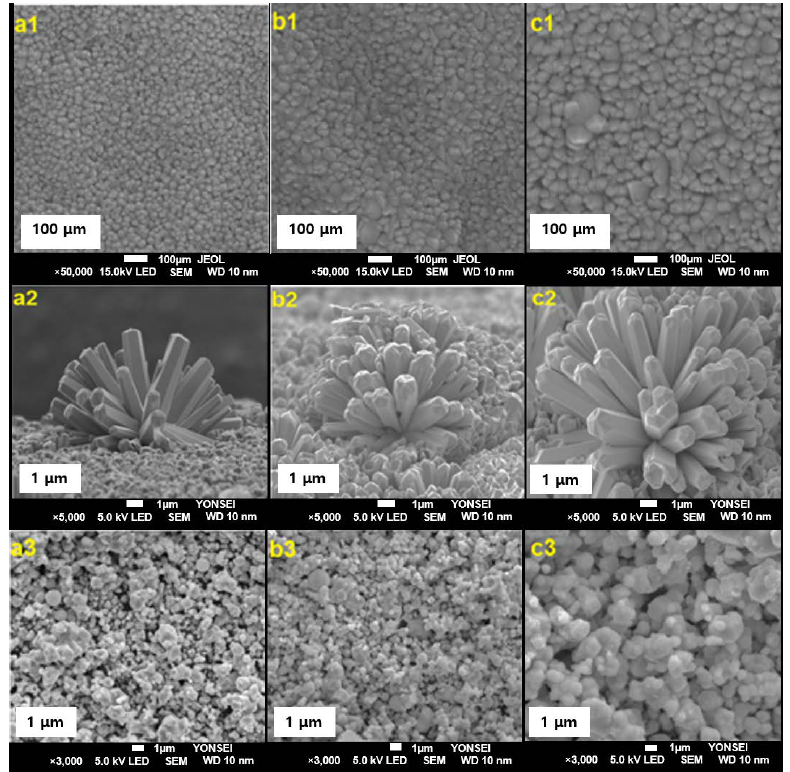
Figure 2. FESEM images of ZnO seed layer ( a1 , b1 , c1 ); ZnO microrods ( a2 , b2 , c2 ) and ZnO/V 2 O 5 composite ( a3 , b3 , c3 ) for deposition time of 10 min, 20 min, and 30 min respectively. Hydrothermally synthesized samples (ZnO and ZnO/V 2 O 5 ) experienced extremely oriented growth which were further studied by XRD and XPS techniques. The XRD studies were plotted in Figure S5 and Figure 3 for ZnO and ZnO/V 2 O 5 , respectively. The expected peaks distinctly appeared which indicate the formation of ZnO microrods for all samples with different deposition times. They showed similar 2 θ values of 31.72 ◦ , 34.38 ◦ , 36.2 ◦ , 47.54 ◦ , 56.62 ◦ and 62.78 ◦ independent of the deposition times as represented in Figure S5. Moreover, the crystallinity and orientation of synthesized ZnO microrods were studied by the intensity of ZnO peaks. The peak heights are slightly attenuated for the 10 min ZnO deposition sample signifying lower crystallinity. These peaks indexed the hexagonal phase of the crystalline structure match with the JCPDS card: (36-1451) [28]. No extra peaks confirm a well-crystalline and pure phase ZnO structure. The sharp diffraction peaks in all samples (Figure 3a–c) at the different seed layer sputtering time on PET films authorized the polycrystalline appearance of nanoparticles. The V 2 O 5 indexed orthorhombic crystalline phase matches with JCPDS: (89-0612) [37]. The other crystalline peaks correspond to the ZnO microrods projecting to increase the crystallinity from sharp peaks. These obtained results indicate that the growth of ZnO microrods are highly oriented to the z -axis and vertically aligned. The crystallinity data are consistent with the FESEM